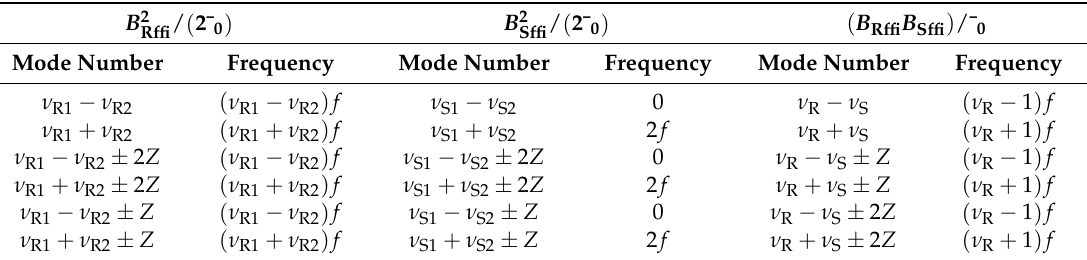
Table 2. The exciting mode number and frequency of p r